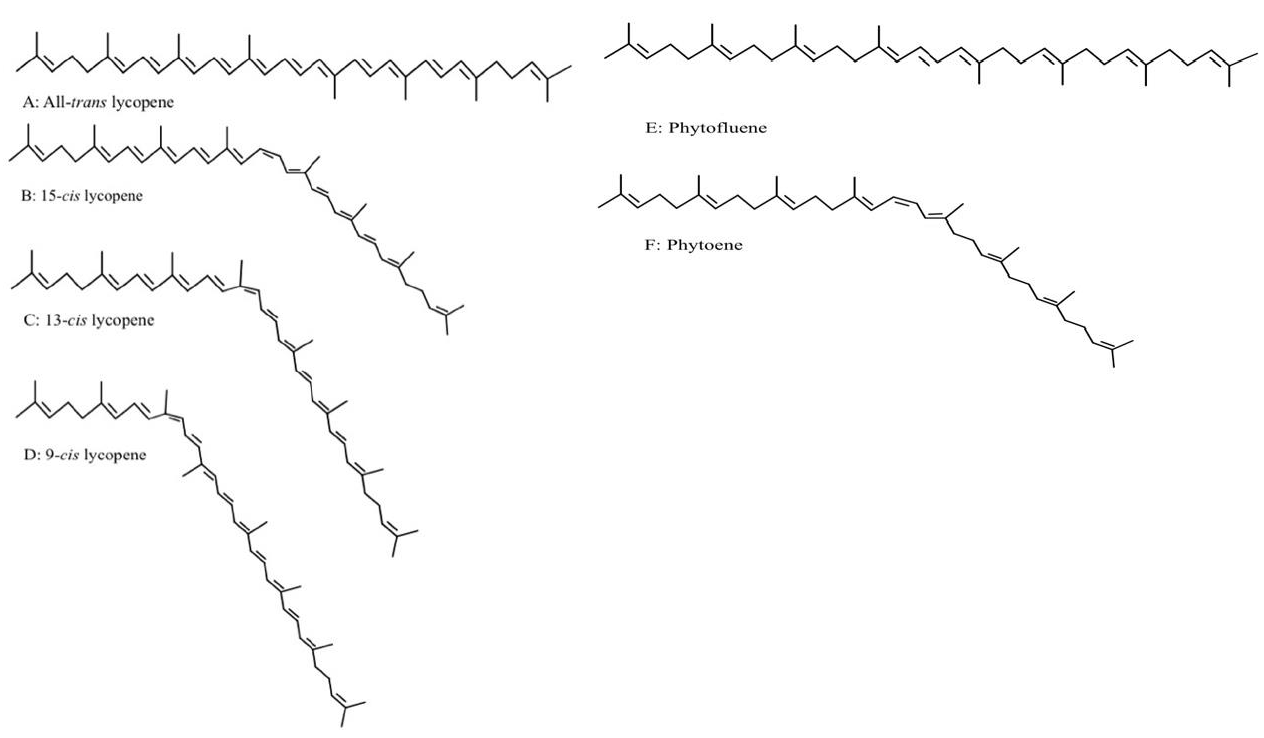
Figure 1. Chemical structure of lycopene, lycopene isomers (15- cis , 13- cis , 9- cis ), phytofluene, and phytoene.